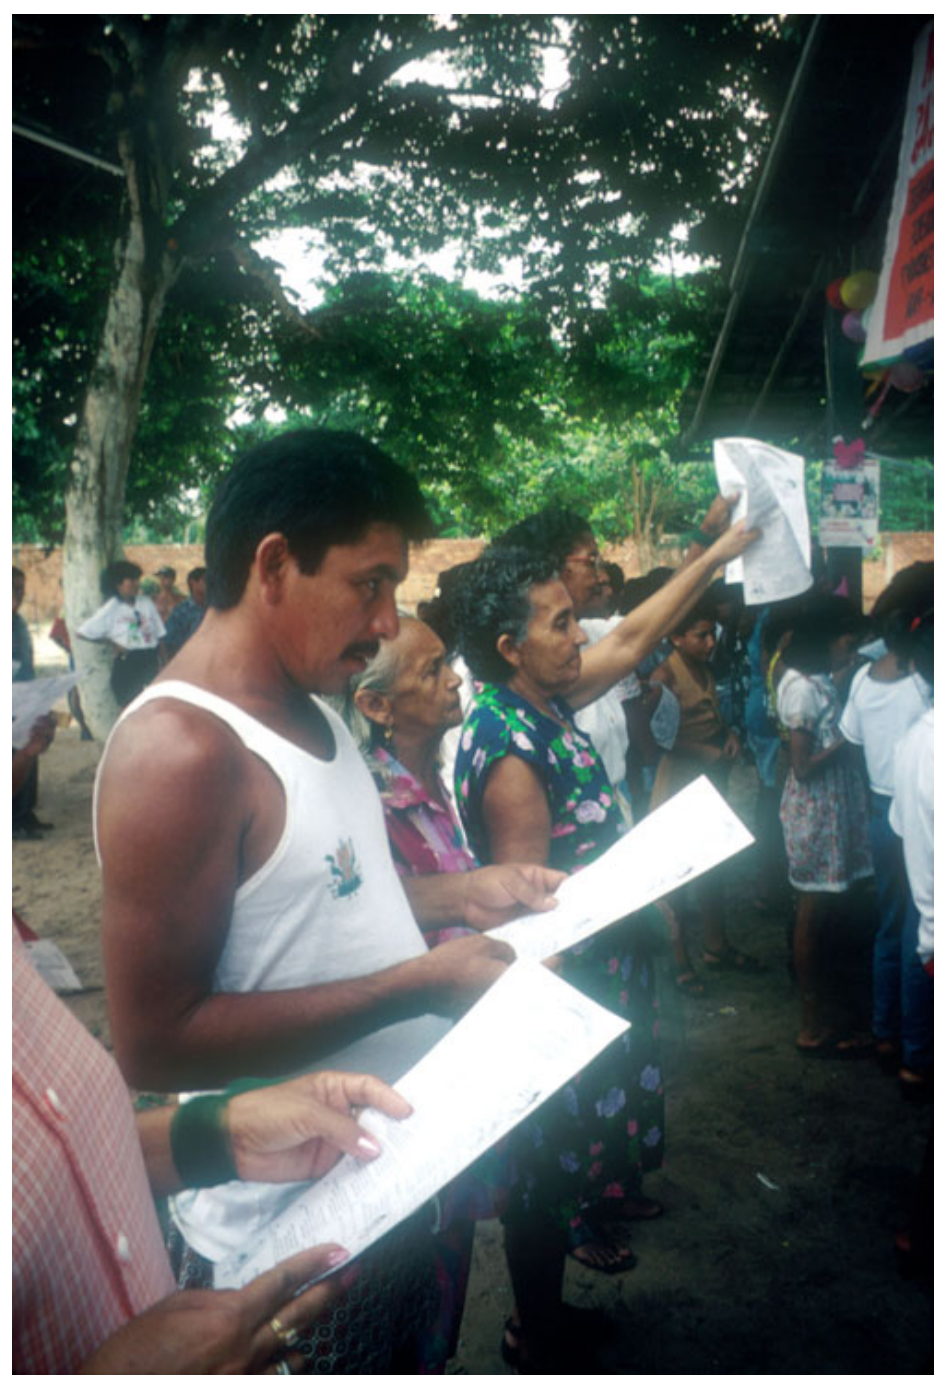
Fig. 12. Brazilian researcher Jurandir Galvão sings a women’s rights song at a demonstration for social and environmental justice. Photo: Patricia